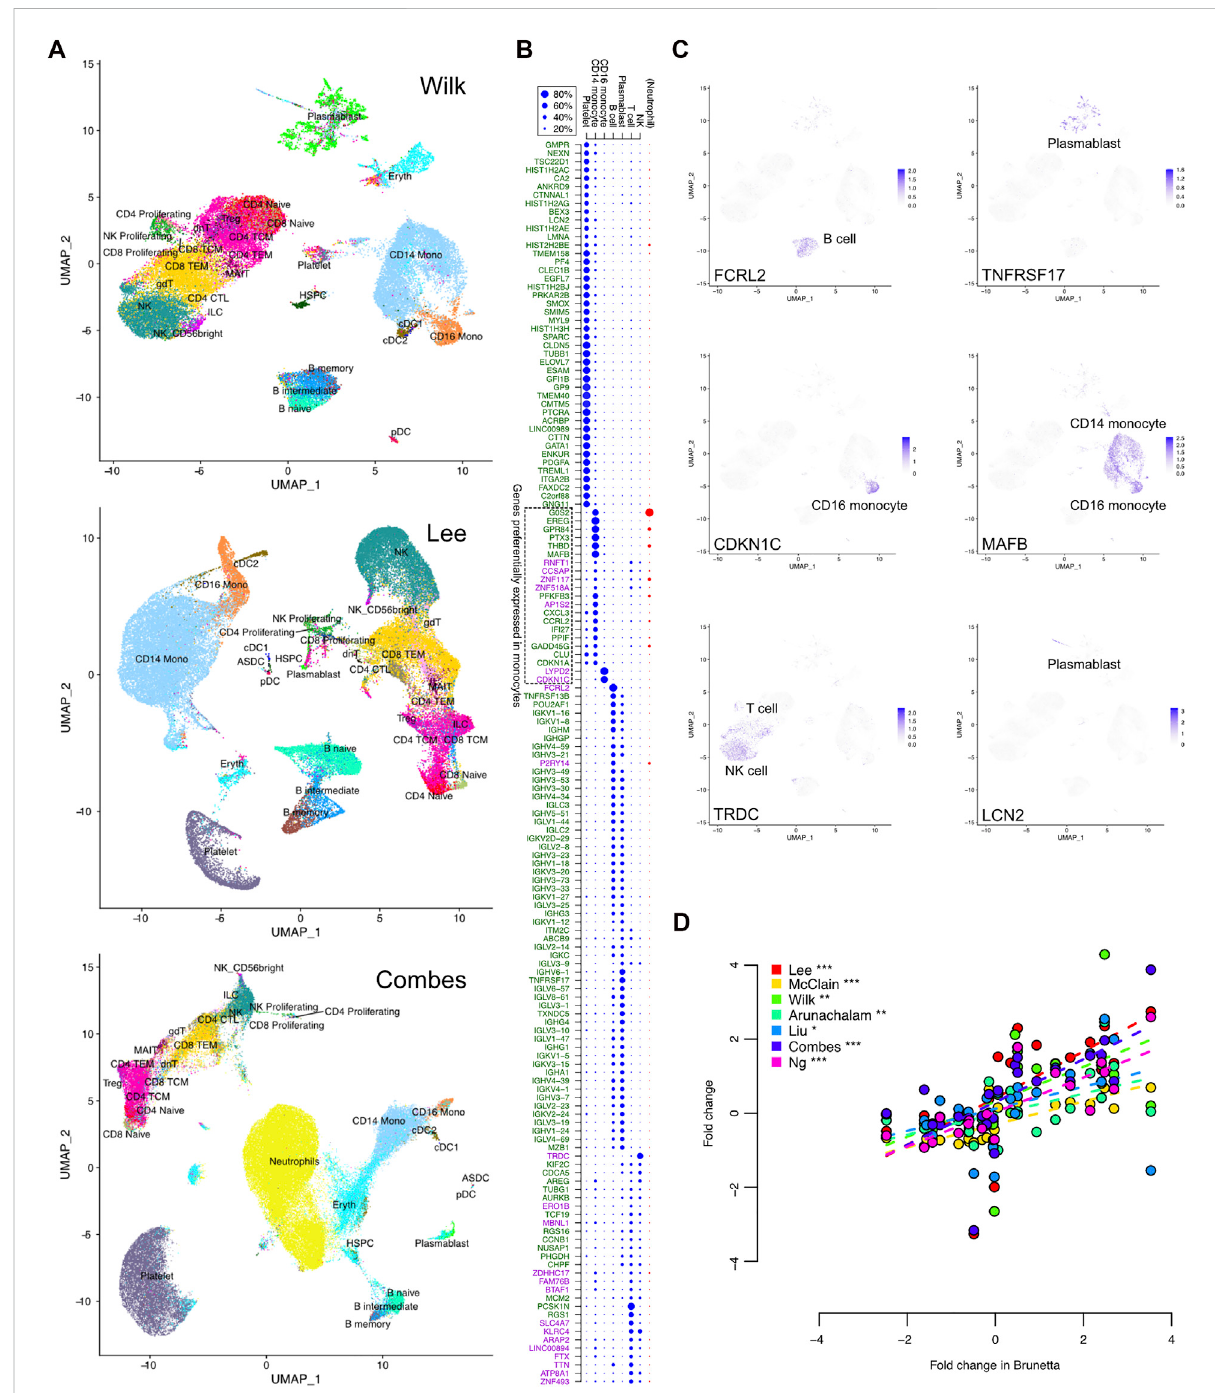
FIGURE 4 COVID-19 speci fi c expression signature in single-cell RNA-seq data. (A) Uniform manifold approximation and projection (UMAP) clustering of the Wilk, Lee, and Combes single-cell RNA-seq datasets together with harmonized cell type annotations. (B) Contribution of the different cell types to the observed bulk expression of the signature genes, as measured by the relative proportions of sequencing reads assigned to the different cell subsets that are common across the datasets. Neutrophil proportion was available only in the Combes data and is shown separately. The upregulated and downregulated COVID-19 speci fi c genes are indicated by the green and purple text, respectively. (C) Expression of selected representative genes in the single cells of the Wilk dataset; visualizations of all signature genes are available in our online tool (https://elolab. shinyapps.io/COVID19/). These include FCRL2 and TNFRSF17 as examples of responses in B cells and blasmablasts, CDKN1C in CD16 monocytes as an example of cell cycle regulation, and LCN2 as an example of a novel marker from a cell population of developing neutrophils de fi ned by Wilk. (D) Comparison of logarithmic fold changes between COVID-19 cases and healthy controls for genes preferentially expressed in monocytes, as indicated in panel (B) . The data are from seven bulk expression datasets ( y -axis) and isolated monocytes ( x -axis, Brunetta data). The signi fi cance of Pearson correlation is indicated with asterisks: * p < 0.05, ** p < 0.01, *** p <